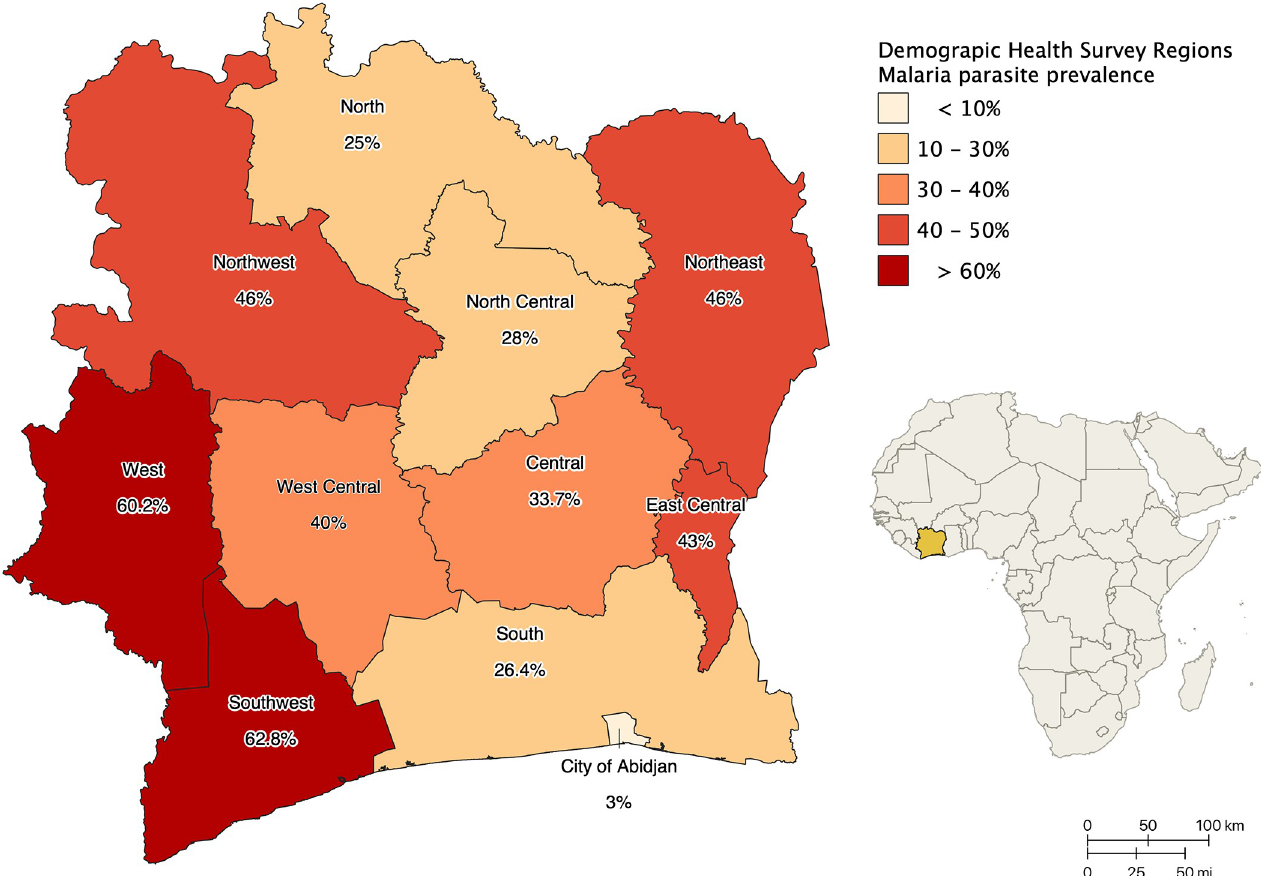
Fig 1. Malaria parasite prevalence by microscopy in children 6–59 months in the districts of Coˆte d’Ivoire, 2016. Data source [18]. Basemap: https://data.